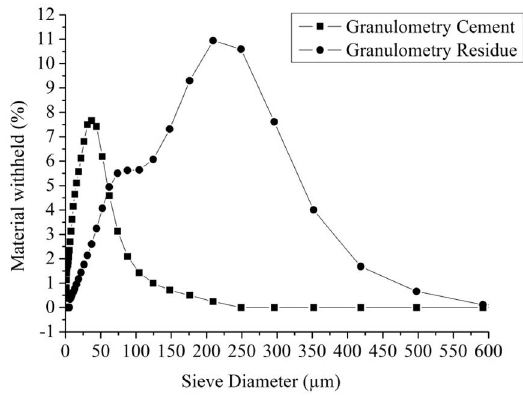
Figure 1. Filer residue and cement granulometric curve.